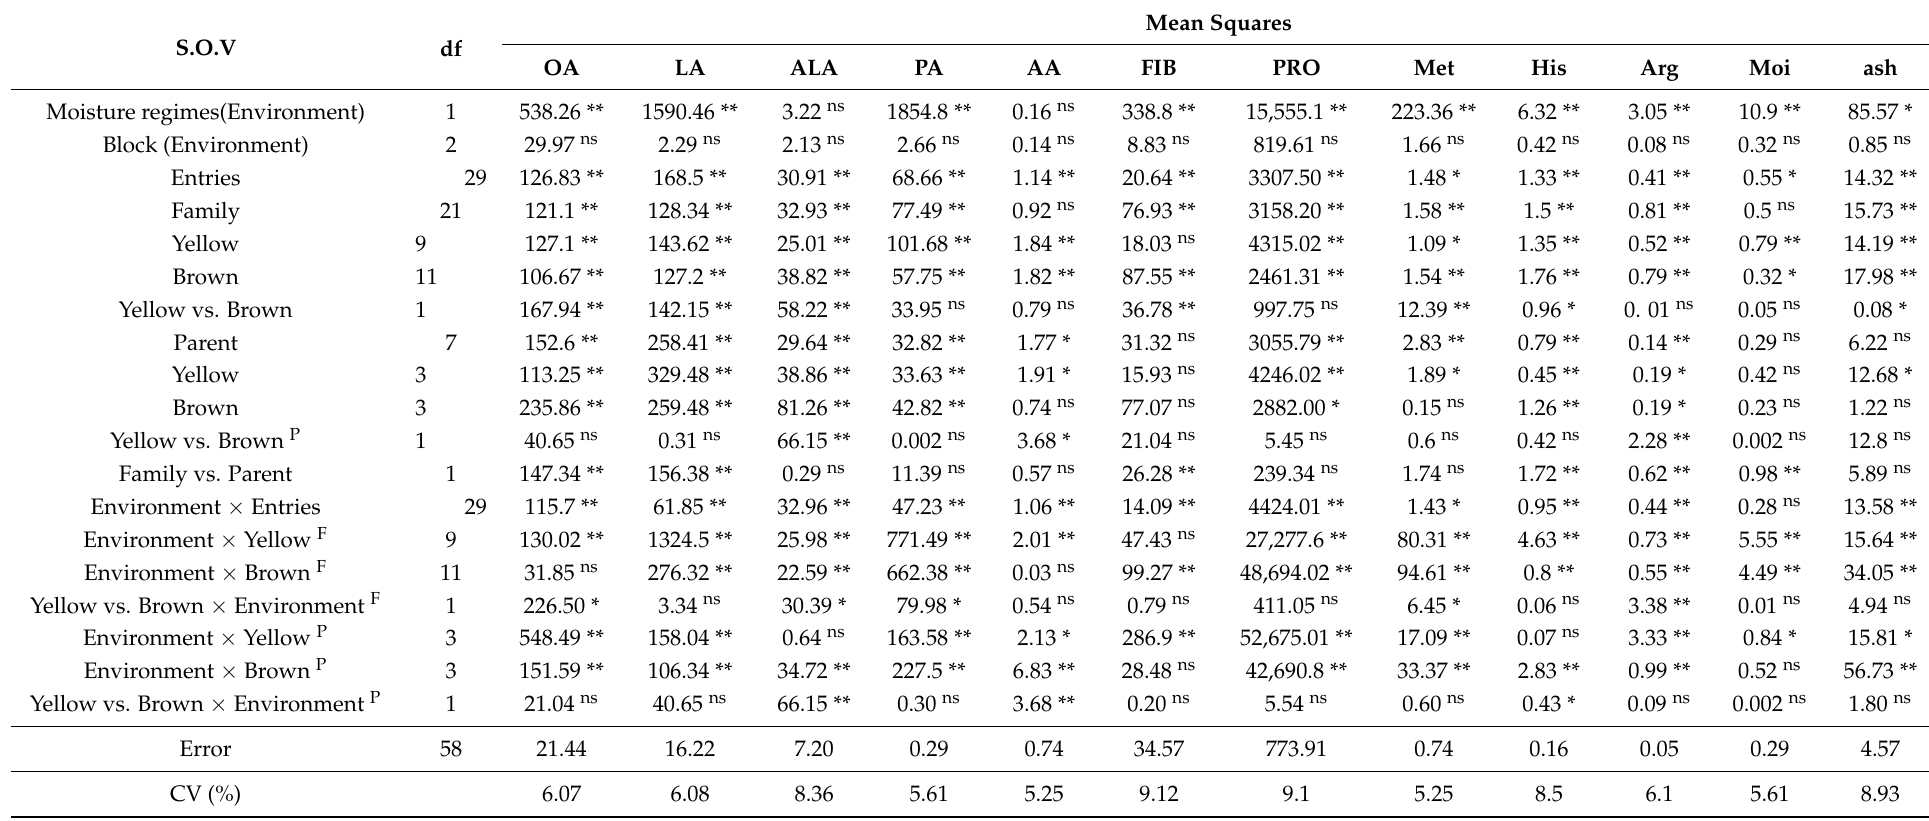
Table 2. Combined analysis of variance (ANOVA) for biochemical characters (NIR) of flaxseed over two environments.